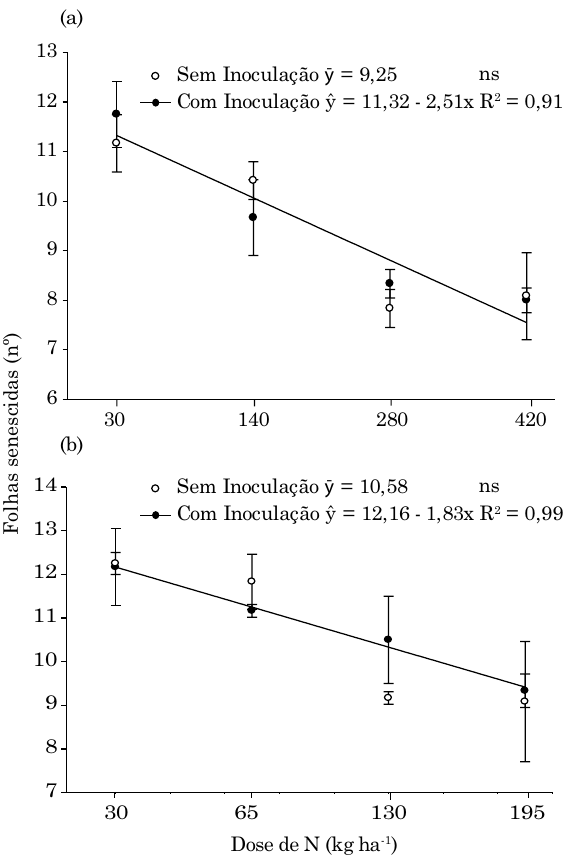
Figura 2. número de folhas senescidas no espigamento do milho em função de doses de nitrogênio, com e sem inoculação das sementes com Azospirillum , nos níveis de manejo alto (a) e médio (b), em lages, sc, durante os anos agrícolas de 2011/2012 e